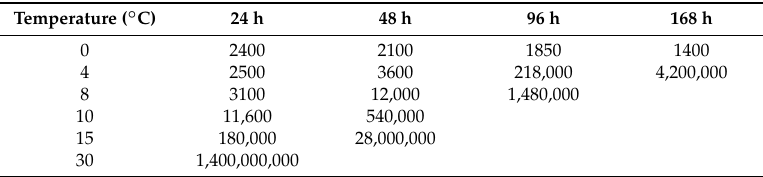
Table 3. Conditions for numbers of bacteria grown in milk